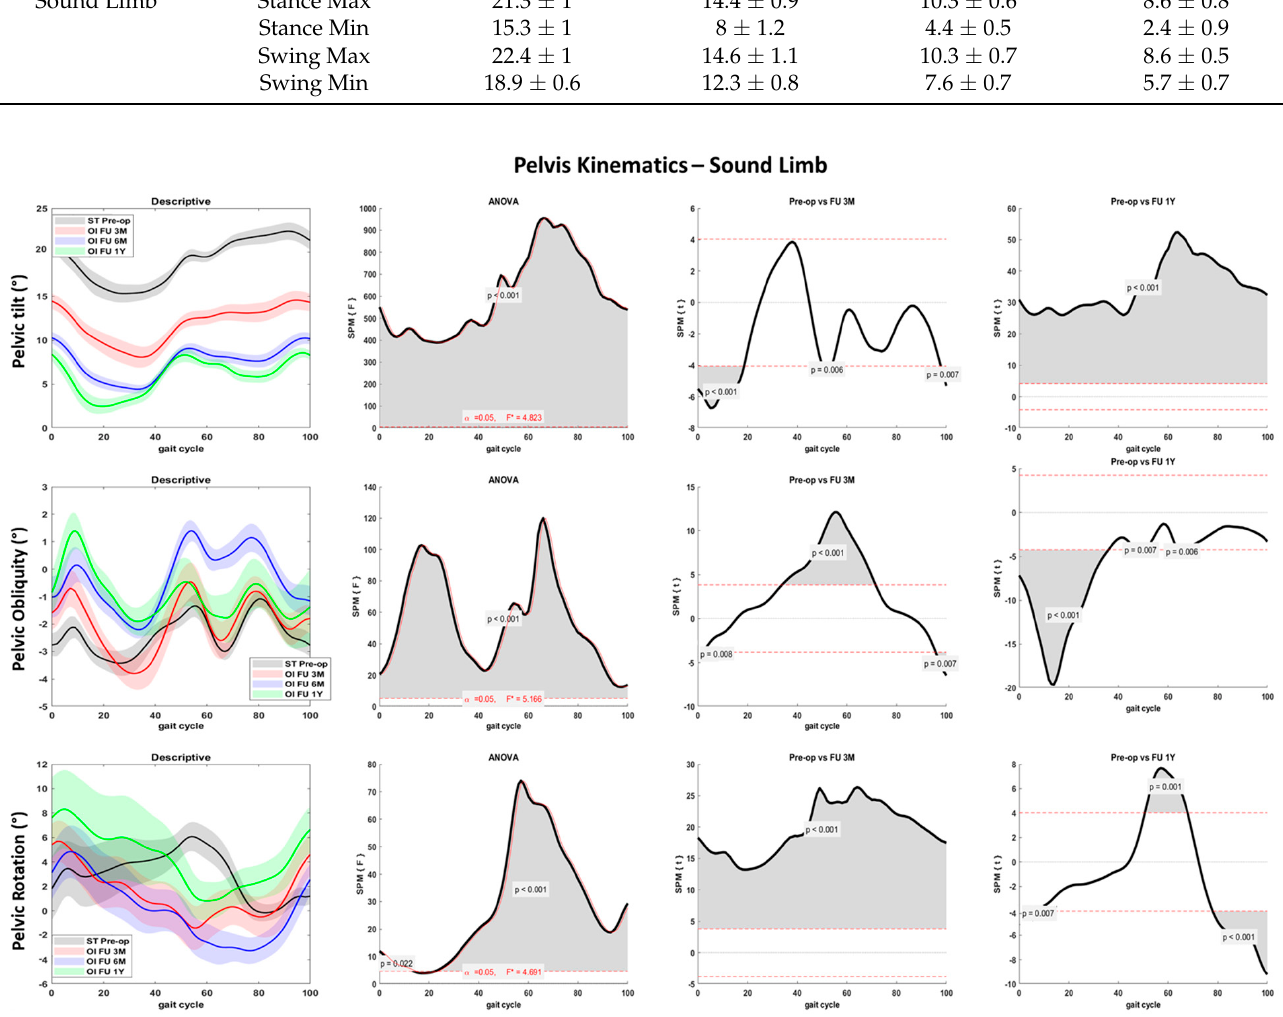
Figure 7. Pelvis joint kinematics over the percentage of gait cycle performed with the sound limb for the fast gait in sagittal (first row), frontal (second row), and transverse (third row) planes. Descriptive data (first column) are expressed as mean (solid line) and standard deviation (dashed line). The gray line represents pre-operative gait analysis with socket-type prosthesis (ST pre-op), the red line represents gait analysis at 3 months follow-up with osseointegrated prosthesis (OI FU 3M), the blue line represents gait analysis at 6 months follow-up with osseointegrated prosthesis (OI FU 6M), the green line represents gait analysis at 1-year follow-up with osseointegrated prosthesis (OI FU 1Y). The results of the spm1D repeated-measure ANOVA are presented in the second column. Gray areas represent statistically signi fi cant di ff erences ( p < 0.05) among the groups. The di ff erences between pre-operative phase and either 3 months follow-up (third column) or 1- year follow-up (fourth column) were assessed through t-test with Bonferroni correction. Table 5. Descriptive peak pelvis kinematics for the amputee and sound limb in the pre-operative gait analysis (socket-type prosthesis, ST) and the follow-up gait analyses (osseointegrated prosthesis, OI). Data are presented for the fast gait as mean ± standard deviation separately for stance and swing phases. Pelvis Kinematics